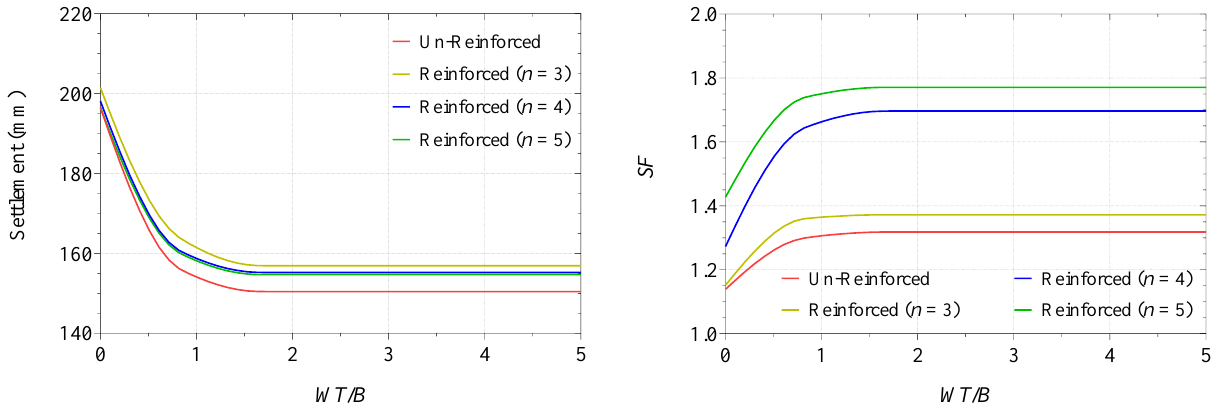
Figure 7. The settlement and the safety factors of the soil-footing system due to the changes of WT/B and n (for all tests: u=0.5 m, h=0.5 m, b=12 m, and St=50